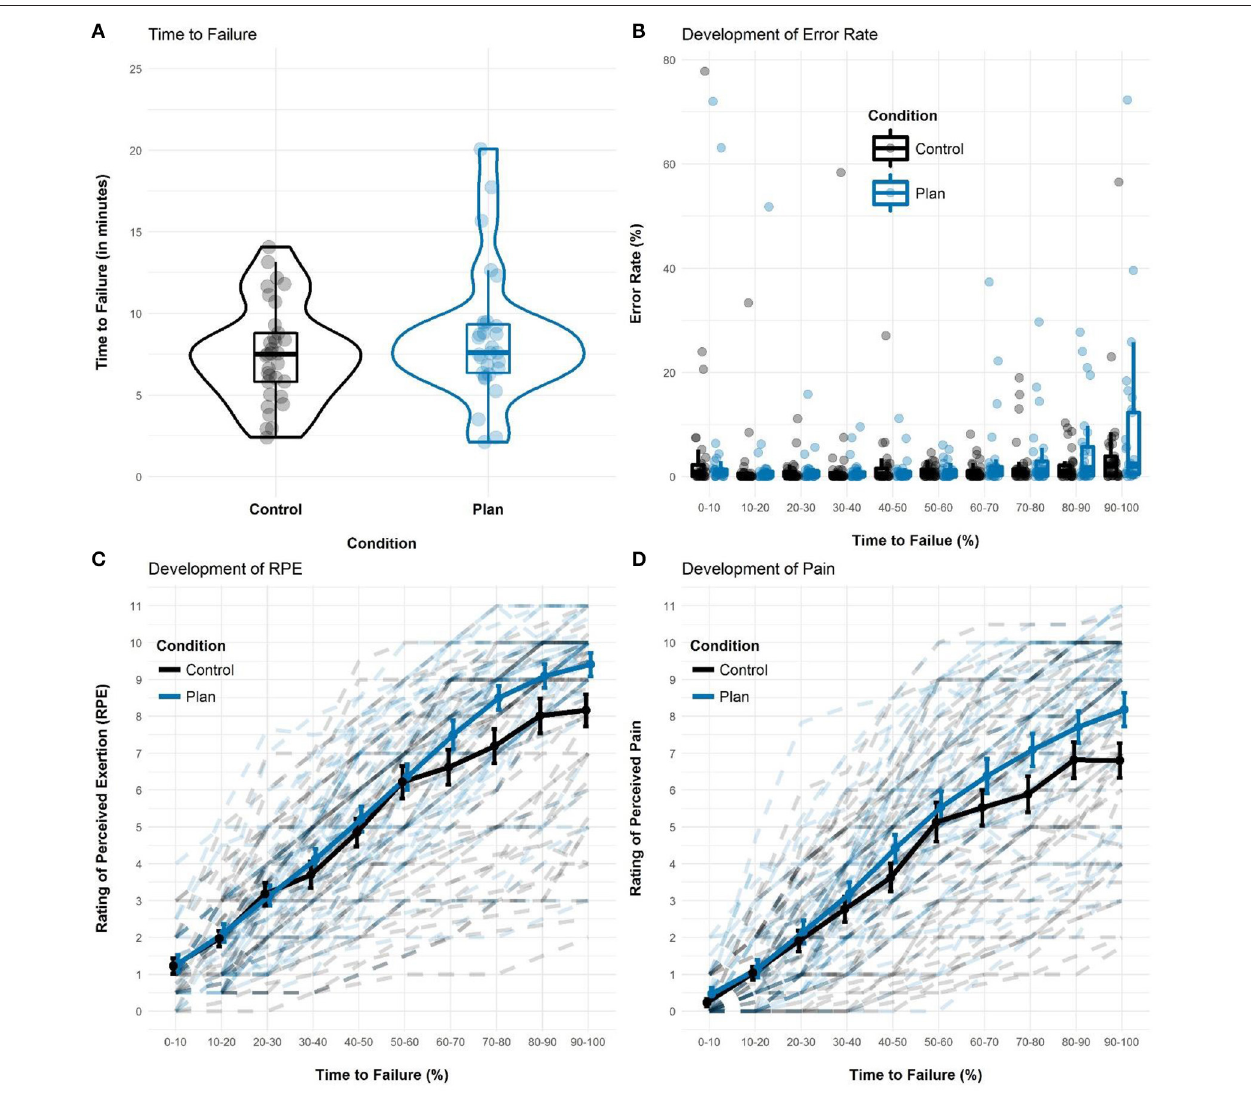
FIGURE 2 | Visualization of results as a function of Condition and Time-to-Failure. Groups did not differ in how long (A) and how accurate (B) they persisted in the static muscular endurance task. Significant between group differences and Time-to-Failure × Condition interactions emerged for RPE (C) and in attenuated form for perceived pain (D) as well. Error bars in (C) and (D) represent standard errors of the